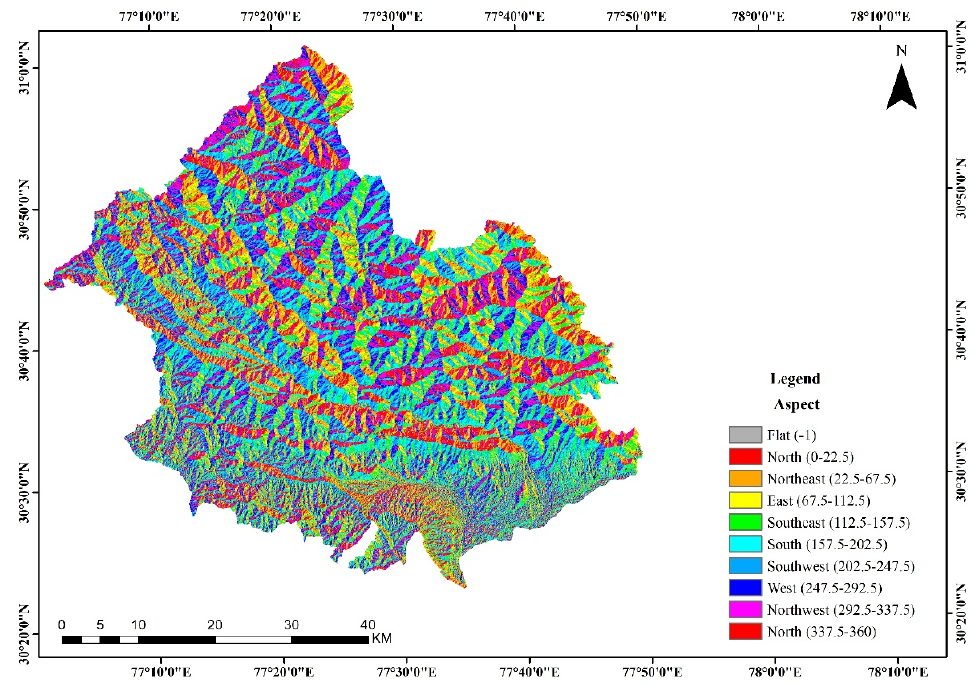
Figure 5. Aspect buffer map.